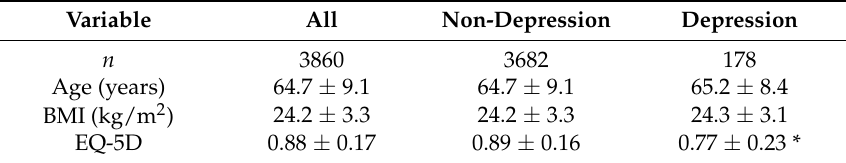
Table 3. Descriptive characteristics of the participants by depression category. Variable